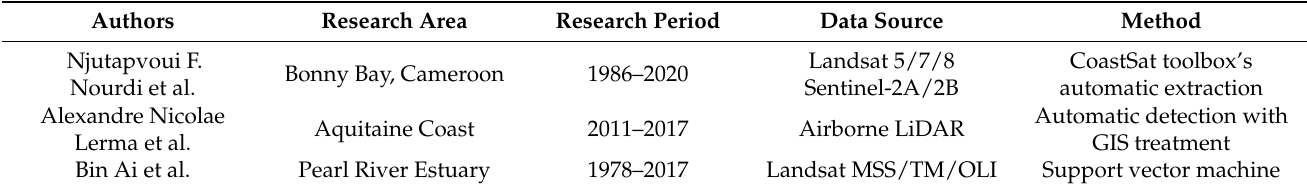
Table 9. Comparison of coastline extraction methods and data from relevant